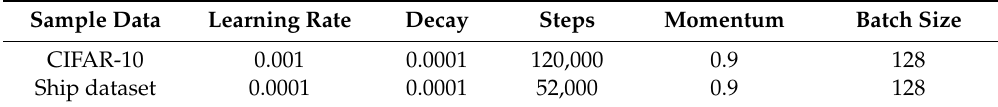
Table 2. Partial training parameters.